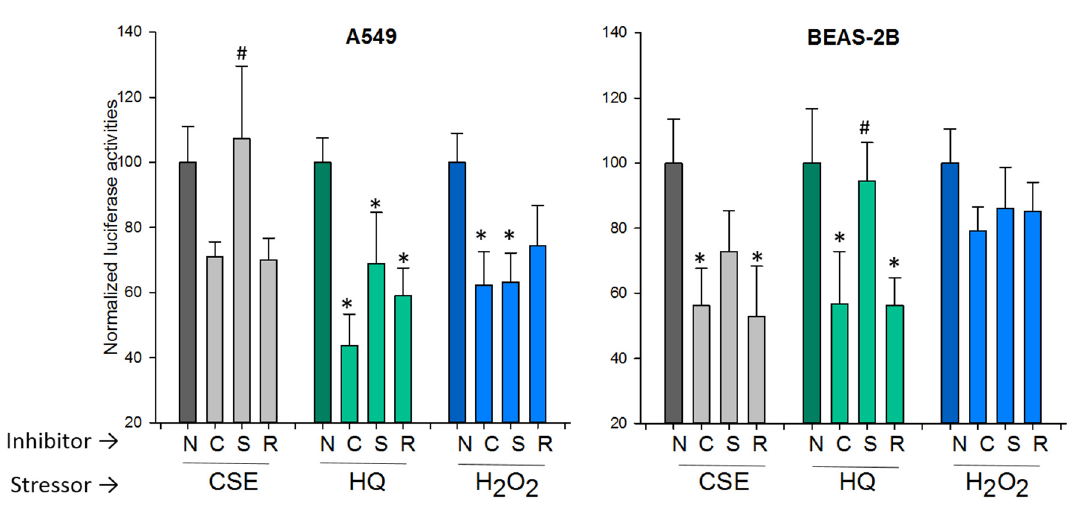
Figure 7. Protection of A549 and BEAS-2B cells from stressors-activators of the p53 pathway by CMC (abbreviated as C), (4 S )-CMCO (S), and (4 R )-CMCO (R). The luciferase activities in the treated cells are normalized for the reporter activity in wells receiving no inhibitor (N). The stressor concentrations are indicated in Figure 6. The inhibitor concentrations were 1 mM in all experiments. The error bars are SDs; n = 3. The differences of means were probed by the one-way ANOVA; * indicates a statistically significant difference between an inhibitor treatment and “no inhibitor” control; # indicates a statistically significant difference between CMC and CMCO treatments, p < 0.05.